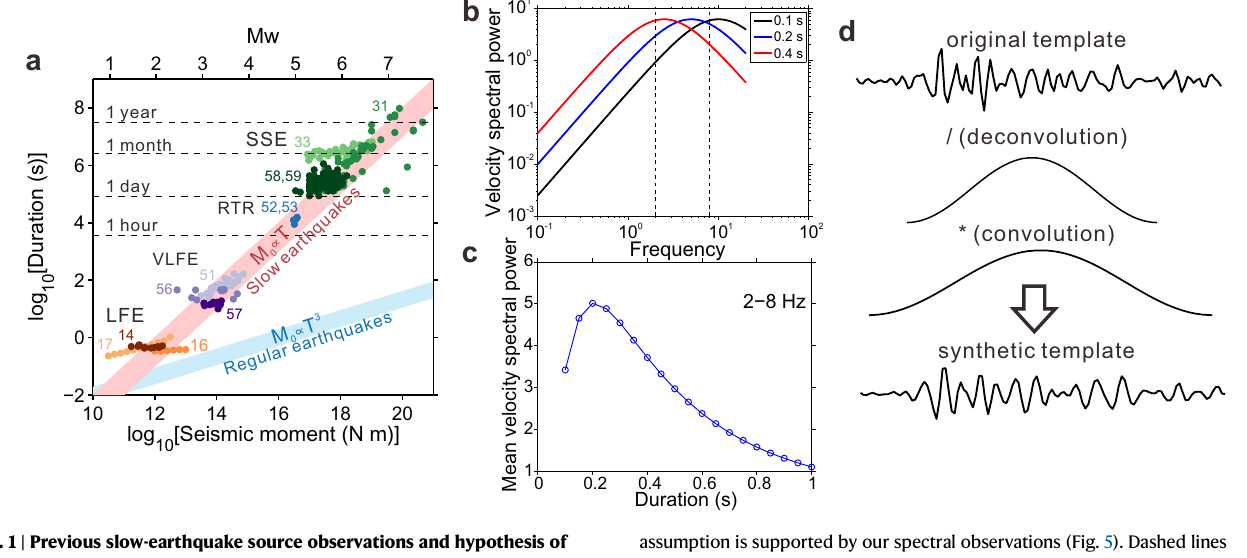
assumption is supported by our spectral observations (Fig. 5). Dashed lines (2 – 8Hz) are the primary observation band of LFEs. c The mean spectral power between 2 and 8Hz band for LFEs with different durations, after convolving with the 2 – 8Hz Butterworth fi lter used in the detection. d shows how we create syn- thetic templates with different durations. We start with an original template built from stacked detections and deconvolve an assumed source time function. Then we convolve with source time functions of different durations.